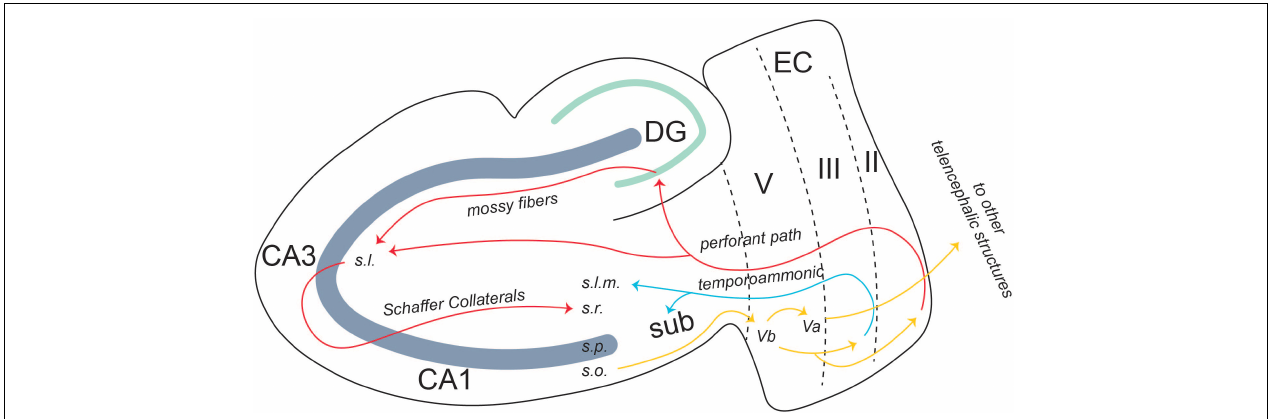
FIGURE 3 | Entorhinal-hippocampal circuitry. There are two pathways of information flow from the EC to the CA1 region: the temporoammonic pathway (originating in layer III) and the perforant path (originating in layer II). From the CA1 region, the information flows back to layer V, where it is projected to other telencephalic structures or back to layers II and III in an entorhinal-hippocampal loop. From Lin (2020).